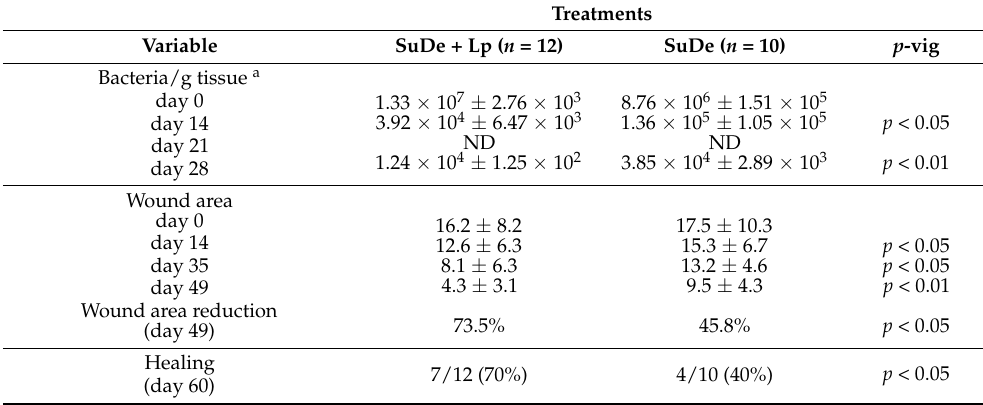
Table 1. Bacterial loads in diabetic foot ulcers (DFUs), percentage of wound area reduction and healing at different time points of the treatment with SuDe + Lp compared with SuDe (mean ± SD). ND: non-determined. p -vig: p -value intergroup. a Total bacterial load.